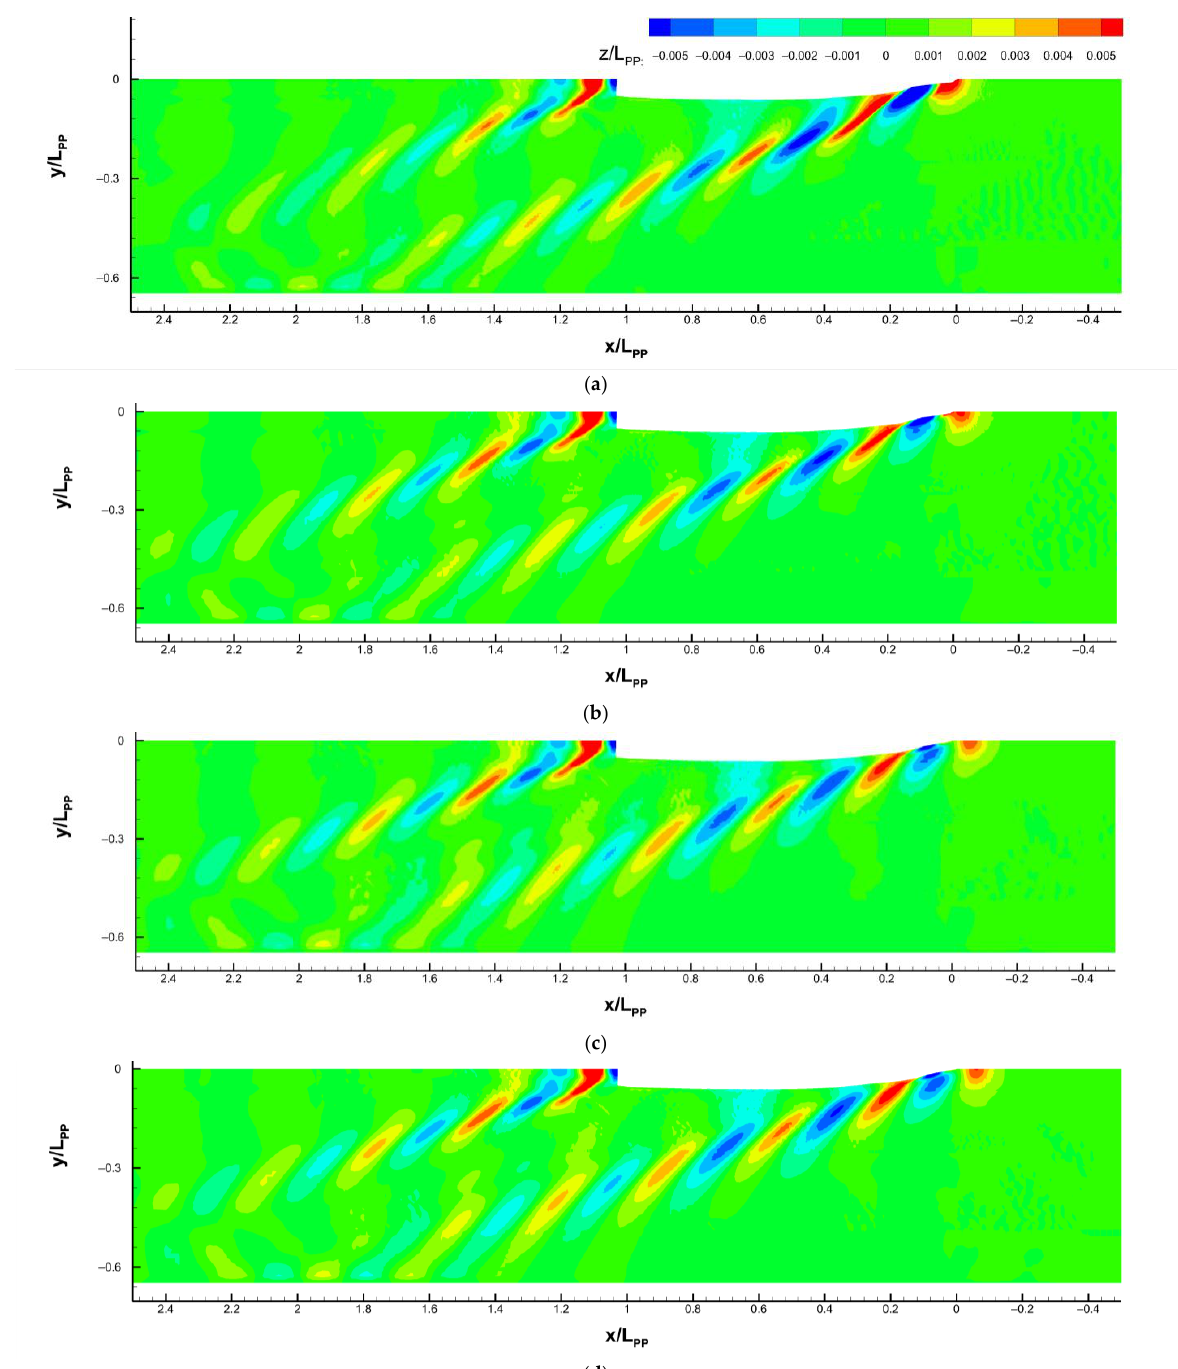
Figure 8. Free surface elevation: ( a ) F0; ( b ) F0.14; ( c ) F0.225; ( d ) F0.24.